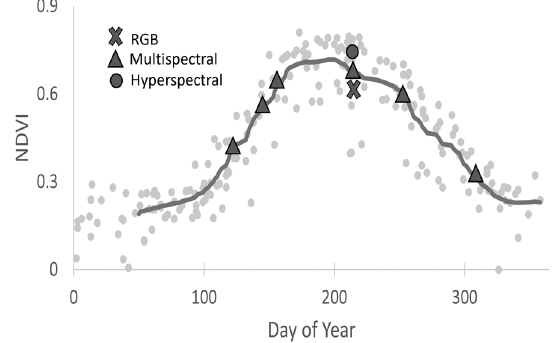
Figure 3. Landsat-derived seasonal patterns of green-up and senescence (acquired between 2004 and 2021) at our tallgrass prairie sites. UAS data acquired during 2020 are overlaid on a 5-day moving average (solid grey line).